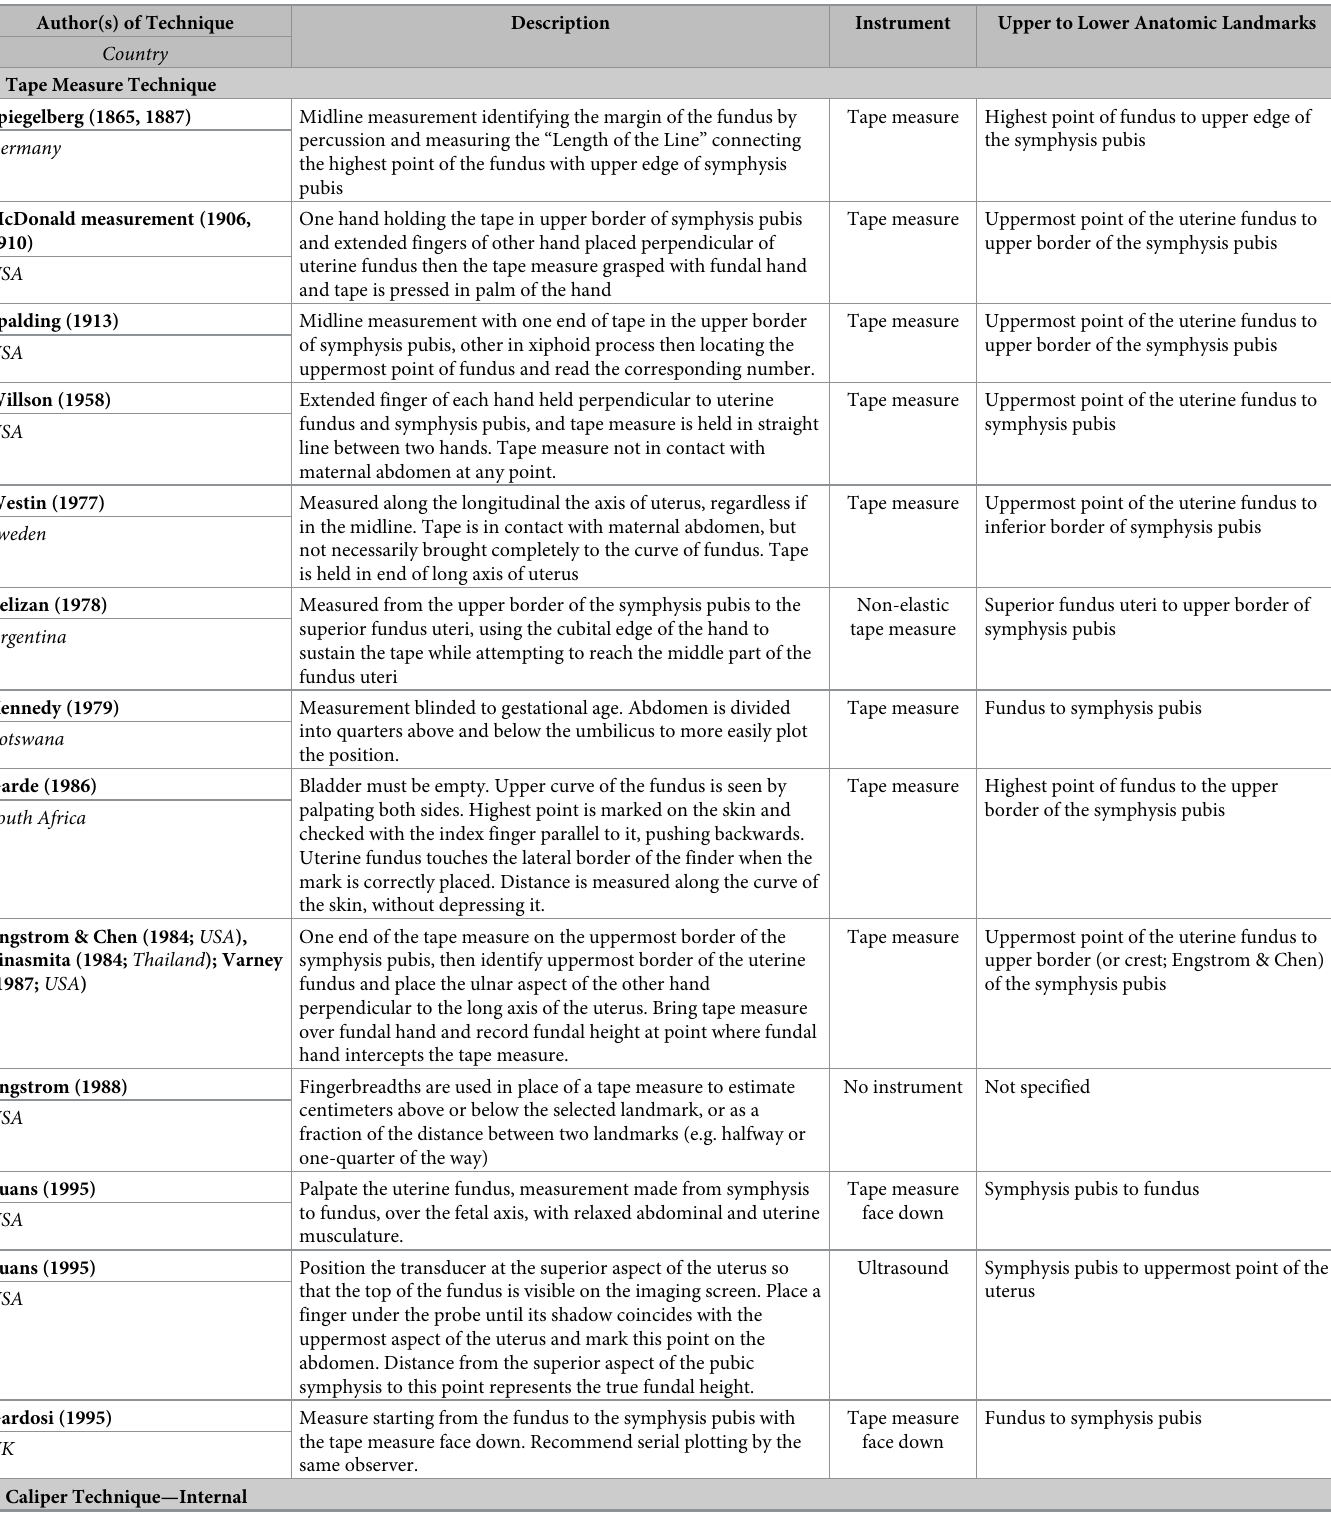
Table 1. Symphysis fundal height measurement